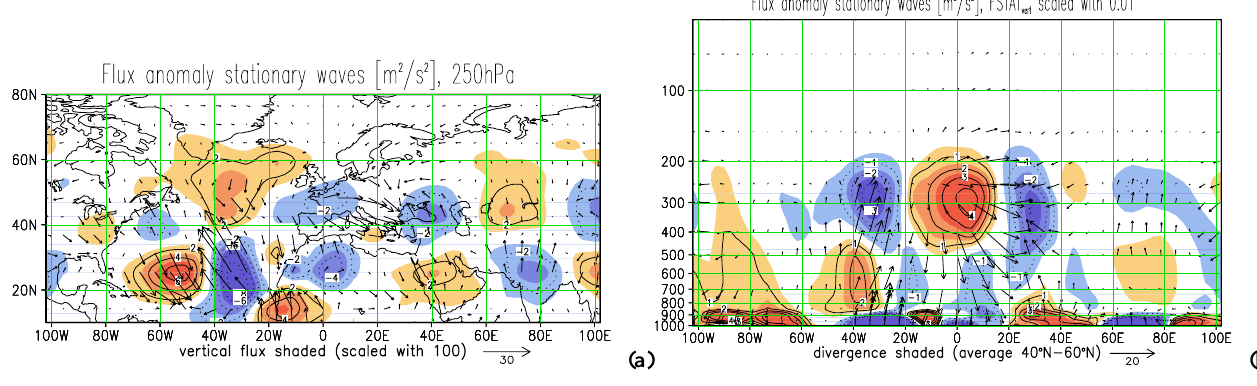
Fig. 6. Stationary flux changes over the North Atlantic. Stationary flux changes (Plumb, 1985) over the North Atlantic due to the ozone anomaly.